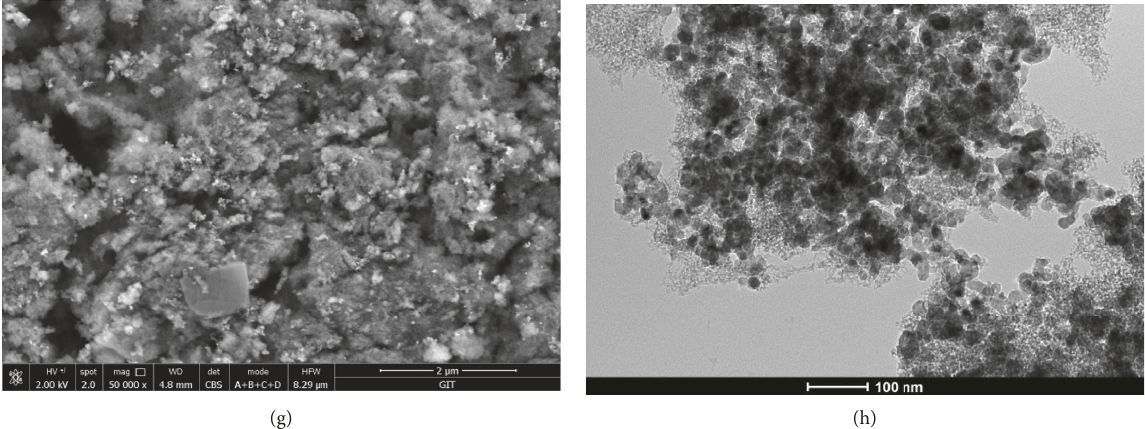
Figure 2: SEM and TEM images of TiN@SiO 2 composite aerogels before and after thermal treatment: SEM (a) and TEM (b) of TiN@SiO 2 ; SEM (c) and TEM (d) of 300-TiO 2 @SiO 2 ; SEM (e) and TEM (f) of 500-TiO 2 @SiO 2 ; SEM (g) and TEM (h) of 700-TiO 2 @SiO 2